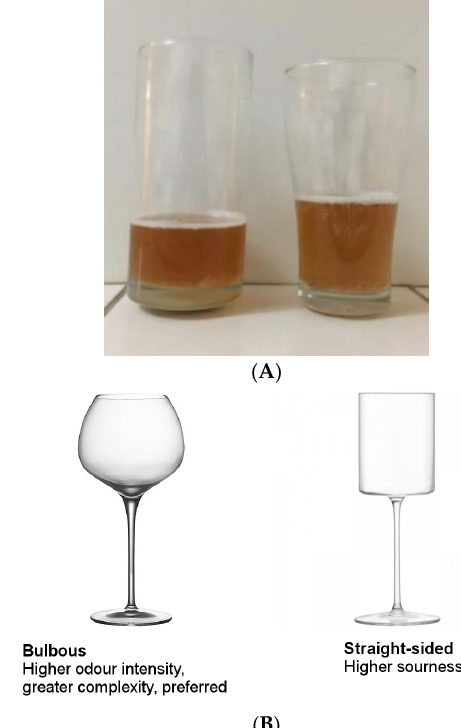
Figure 2. ( A ) Side ‐ view of the straight and curved glasses with 100 mL Yenda Pale Ale in each glass as used in Mirabito et al.’s (2017) study [31]; ( B ) Summary of the key result to emerge from Hummel et al.’s (2003) [21] study of the impact of glass shape on the perception of fruity aroma in wine. ( A ) is reproduced with permission from [31], © 2017 Elsevier Ltd.